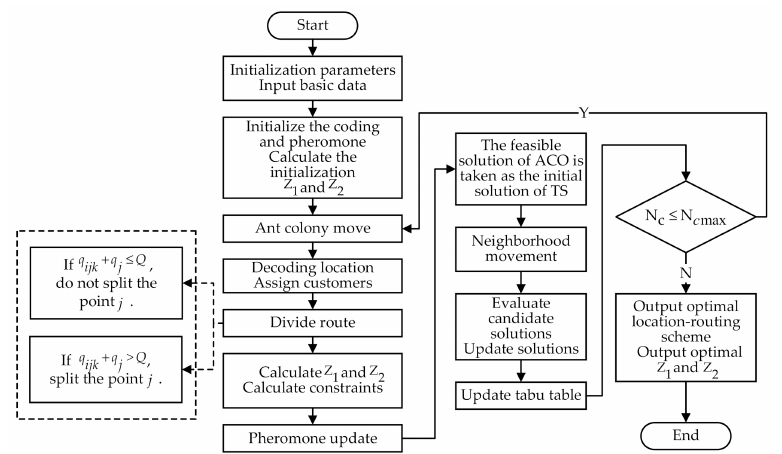
Figure 4. Hybrid algorithm flow chart of ACO-TS.